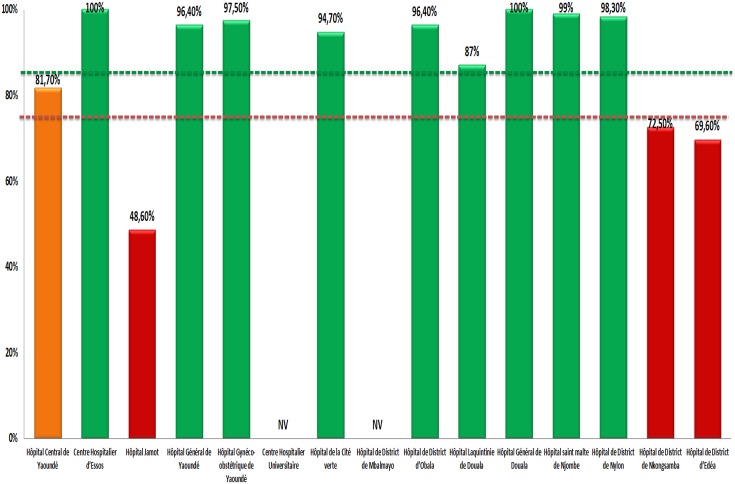
Site Performance for “Retention in Care 12 months after ART Initiation” in 2013.NV, Not Validated; green, desirable performance; amber, fair performance; red, poor performance. Horizontal lines indicate the lower limit thresholds for “desirable” (in “green” color) and for “fair” (in “amber” color) performance.